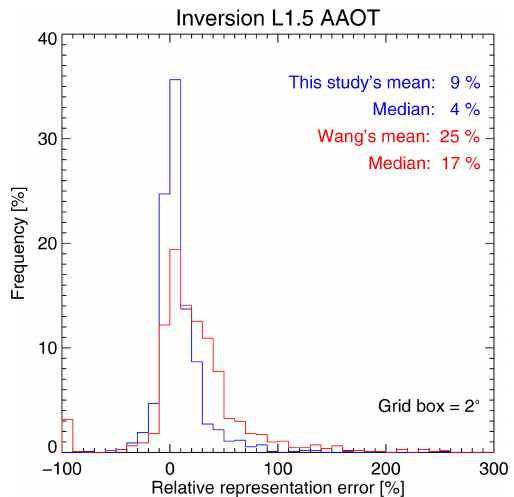
Figure 14. Yearly representation errors for AAOT from inversion L1.5 AERONET as estimated in this paper or using the methodol- ogy from Wang et al. (2018) and a model grid-box size of 2 ◦ . The representation error shown is the spatial representation error (Schut- gens et al., 2017); i.e. temporal sampling of observations is ignored.